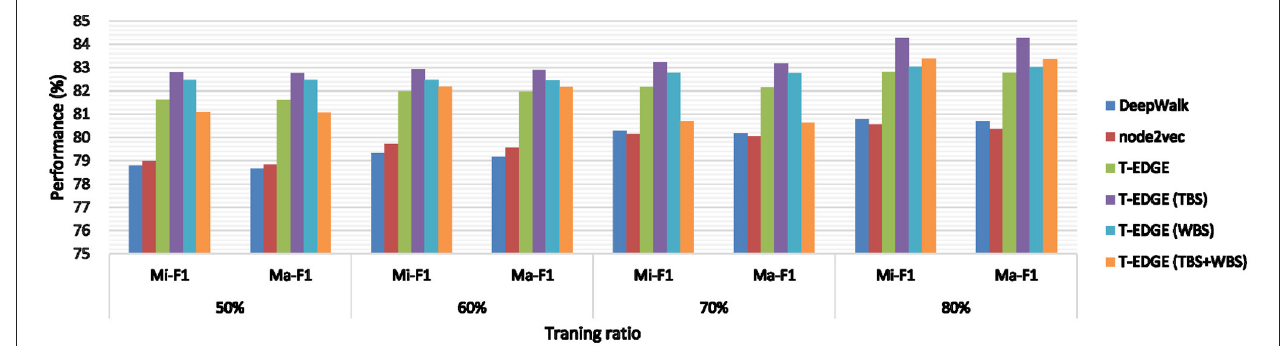
FIGURE 4 | Node classification performance with different training